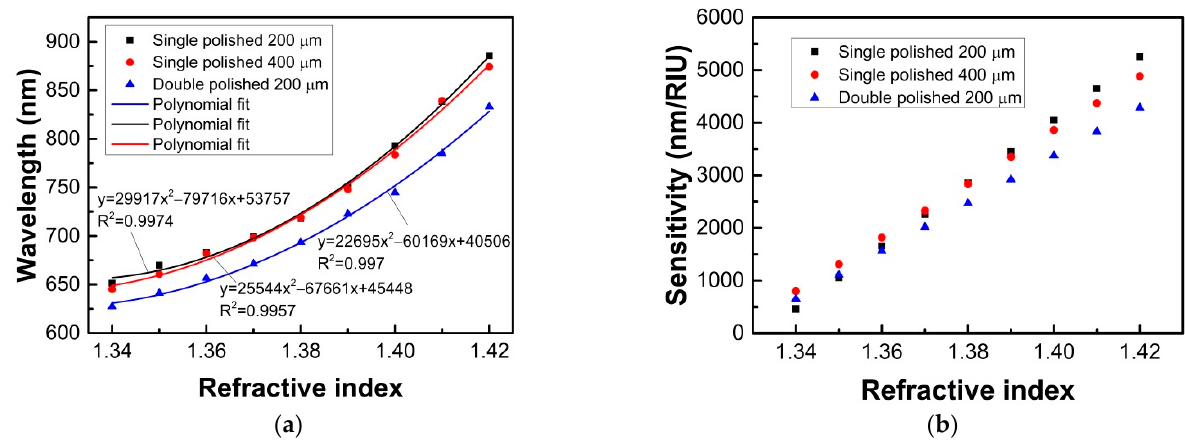
Figure 11. Resonance wavelength peaks as a function of the RI ranging from 1.34 to 1.42 ( a ), and the sensitivities ( b ) for the single and double-sided polished sensor probes.